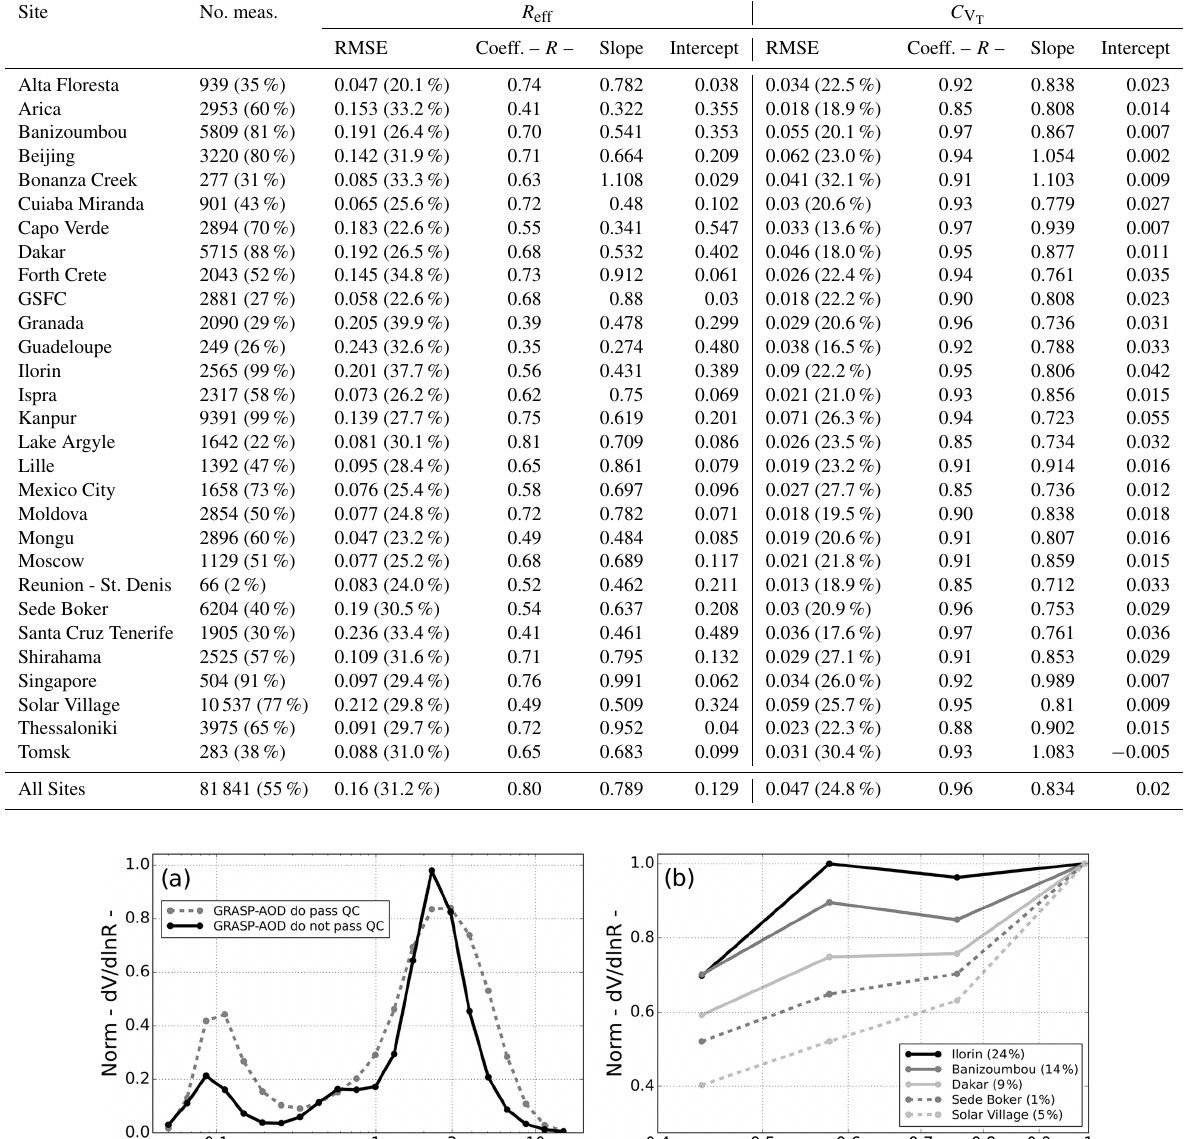
Table 8. Comparison between effective radius and total concentration obtained from the AERONET standard inversion and GRASP-AOD. The first column presents the site and the second column the number of coincident retrievals accomplishing τ( 440 ) > 0 . 2. The percentage with respect to the total number of coincident retrievals is indicated in parentheses. Columns three to six show the comparison results for effective radius, while columns 7 to 10 present the results for the total volume concentration. In both cases, RMSE (and RMSRE enclosed in parentheses) correlation coefficients, slopes and intercepts from linear regressions are shown.